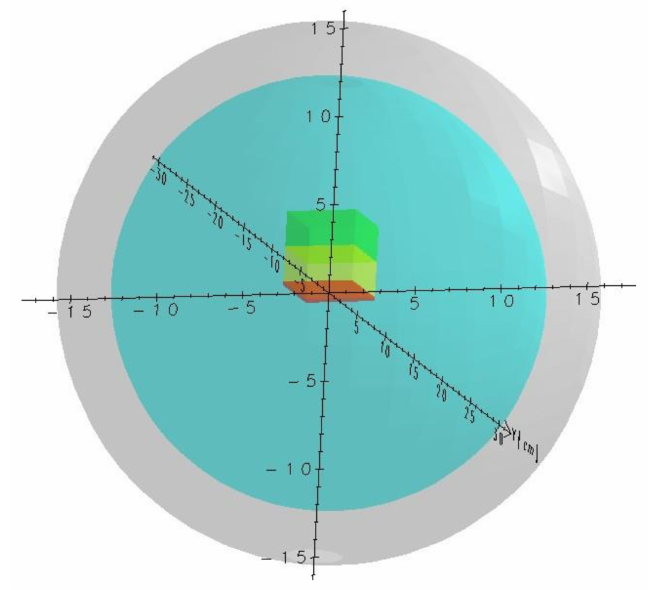
Figure 1. Two zones geometry and the SS304 alloy layer. Orange-SS304 alloy (2 × 2 × 0.2 cm), Yellow and green (2 × 2 × 2 cm)—He layers, azure—source zone (12 cm), gray—geometry end (15 cm).